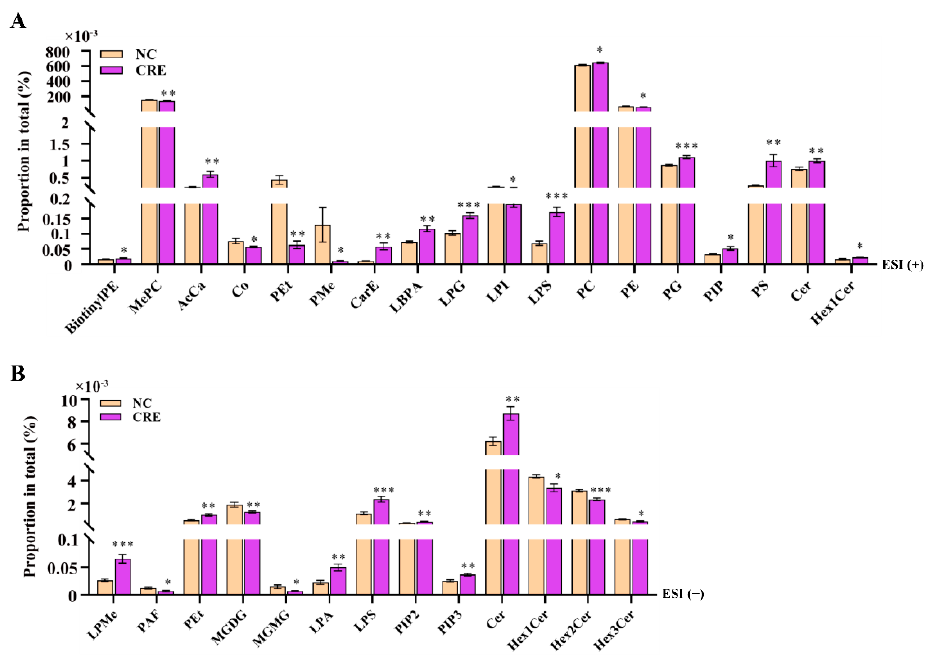
Figure 6. Paired comparison of the lipid composition in mice with or without CRE infection analyzed via the positive ion ( A ) and negative ion modes ( B ). Data are presented as mean ± SEM. * p < 0.05, ** p < 0.01, *** p < 0.001.